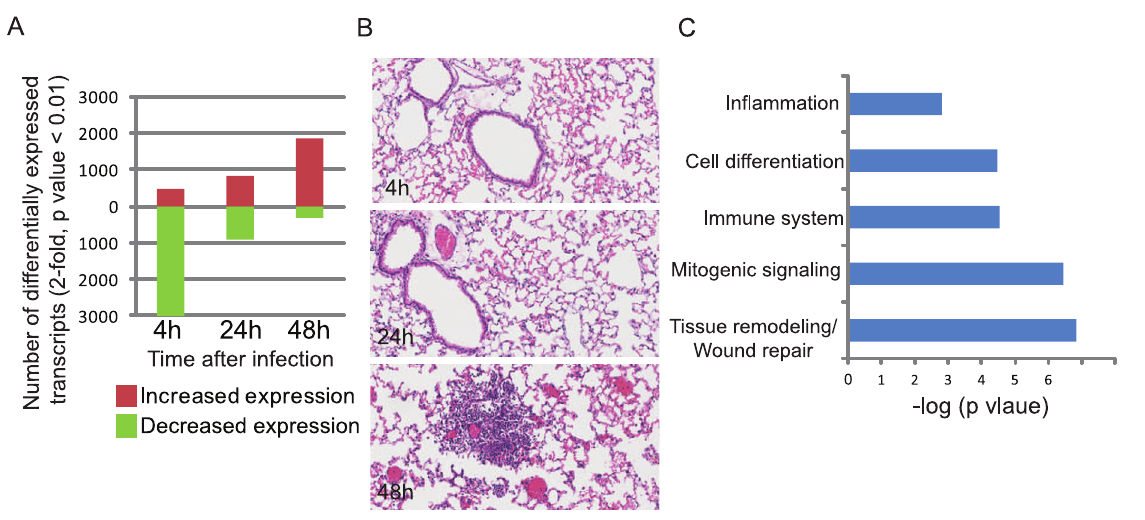
Figure 1. Global host transcriptional response in the lungs of animals following aerosol exposure to virulent F.tularensis . A . Number of transcripts that are differentially expressed (at least 2-fold difference in median expression level, p value 0.01) in the lungs of animals exposed to FT SchuS4 at 4, 24 and 48 hrs post-exposure. Transcripts showing increased or decreased expression relative to control animals are shown in red and green bars, respectively. B. Hematoxylin and eosin stained lung tissue from animals exposed to FT SchuS4. Magnification 20x. C. Gene ontology analysis of approximately 400 transcripts induced by FT SchuS4 at 4 hrs demonstrating enrichment of specific functional groups.